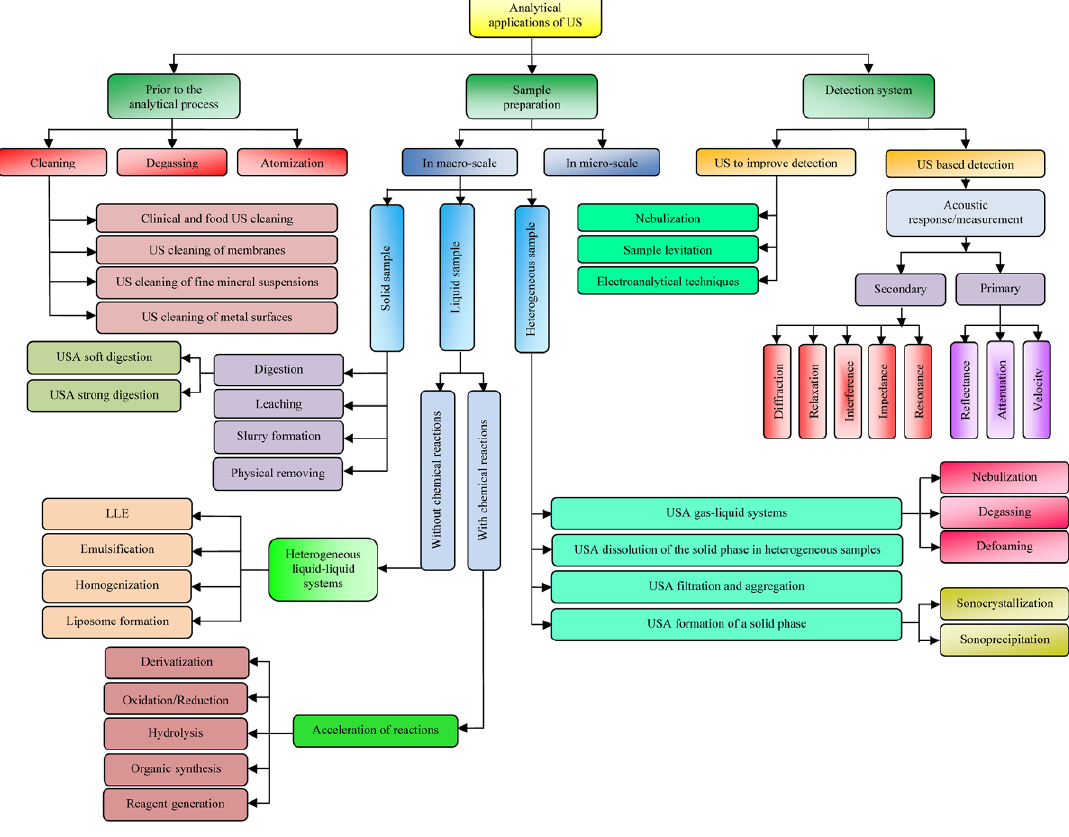
Figure 3. The different steps of the analytical process which can be expedited and/or improved by use of ultrasound